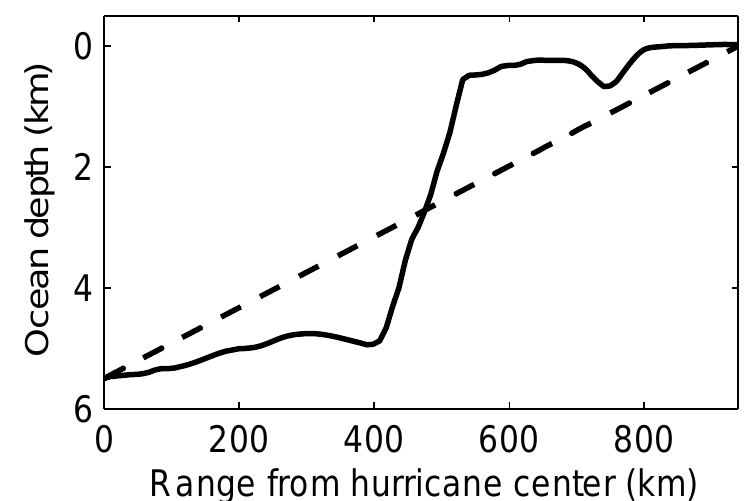
Figure 4. The ocean depth (solid line) between hurricane Bonnie and the seismometer in Florida at noon on 24 August. Also shown is the ocean depth for the idealized up-sloping environment used to calculate the Green functions in Section 3 (dashed line). The scale of the figure makes the actual slope appear to change rapidly; however, the maximum slope of the ocean floor is roughly 3 ◦